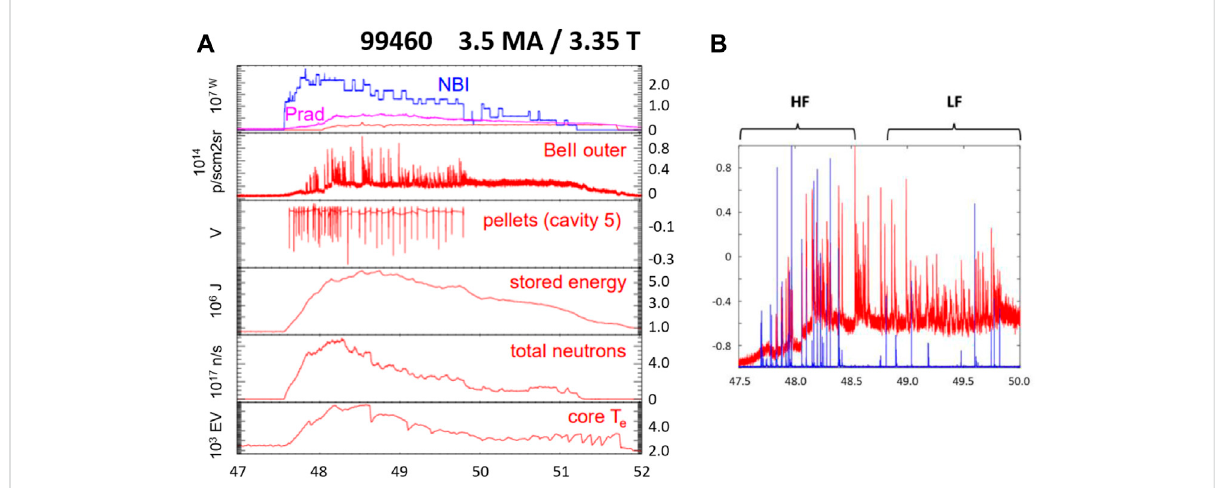
FIGURE 12 Typicalsetupofthepelletfrequencyinthedischargesofthebaselinescenariofortheoperationathighcurrent. (A) fromtoptobottom:neutral beam power and total emitted radiation, BeII to detect the ELMs, microwave cavity to determine the pellets timing, total plasma internal energy, neutron of emission, central electron temperature. On the (B) an expanded view of BeII and the microwave cavity